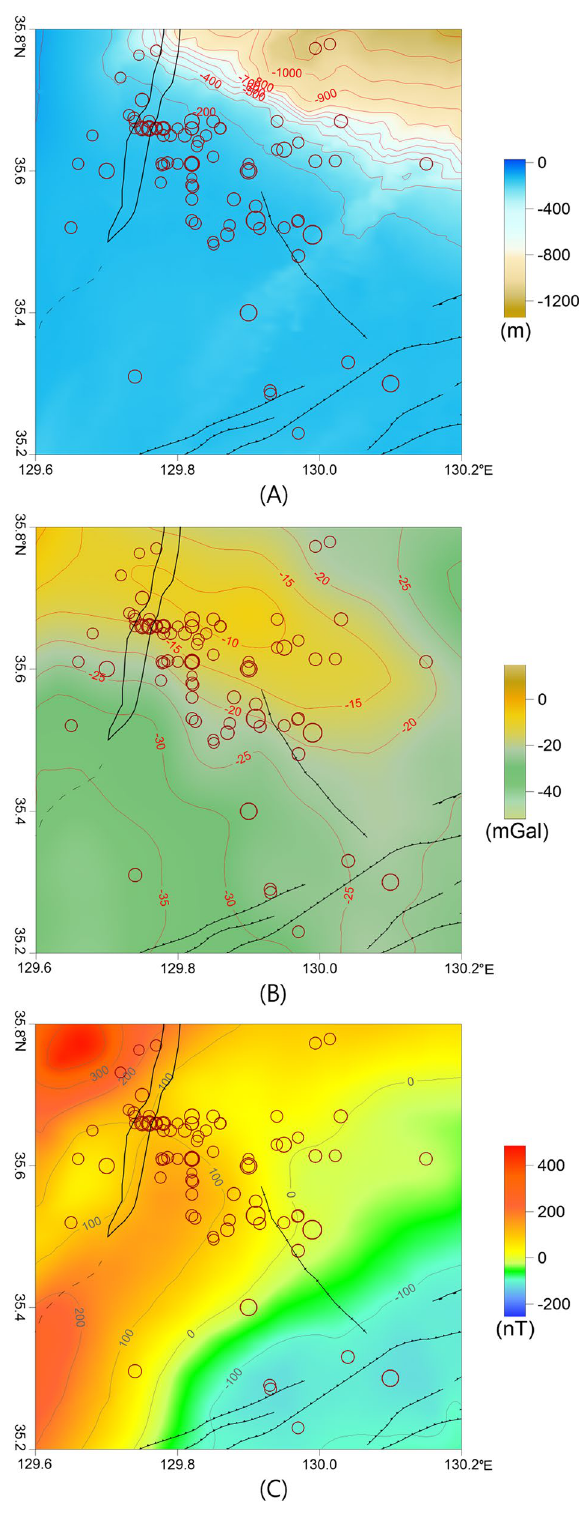
Figure 12. ( A ) Bathymetry map, ( B ) isostasy gravity anomaly map, and ( C ) RTP magnetic anomaly map of the Ulsan offshore region. The major geologic structures and symbols of the earthquakes are the same as those in Fig. 2. These figures were generated using the Surfer software (https:// www. golde nsoft ware.